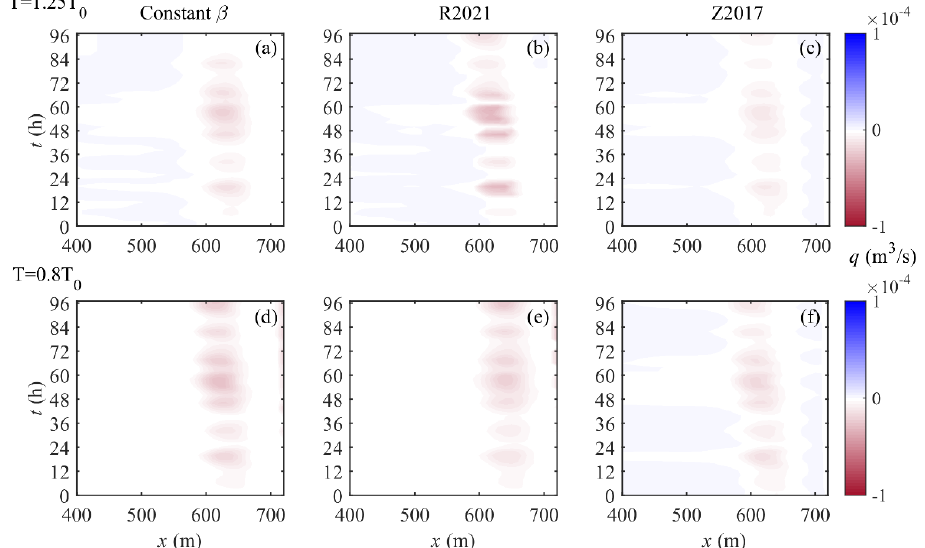
Figure 10. Spatial–temporal evolution of the suspended sediment transport rate predicted by con- stant roller slope (a, d) and the roller slope of R2021 (b, e) and Z2017 (c, f) under two different wave periods. Figs 10a,b,c are calculated with T = 1.25 T 0 , and figures 10d,e,f are calculated with T = 0.8 T 0 .